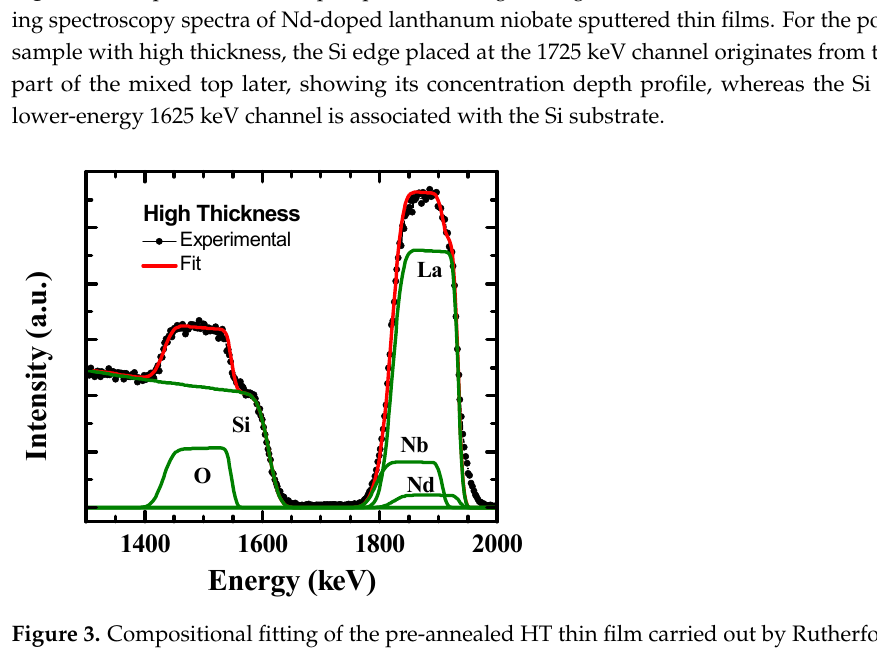
Figure 3. Compositional fitting of the pre-annealed HT thin film carried out by Rutherford backscat- tering spectroscopy.